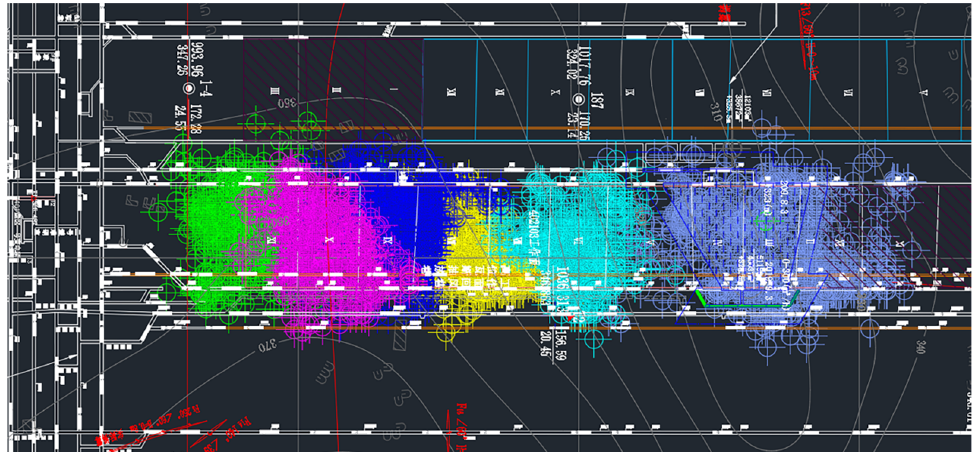
Figure 11. Distribution of microseism clusters on working face.